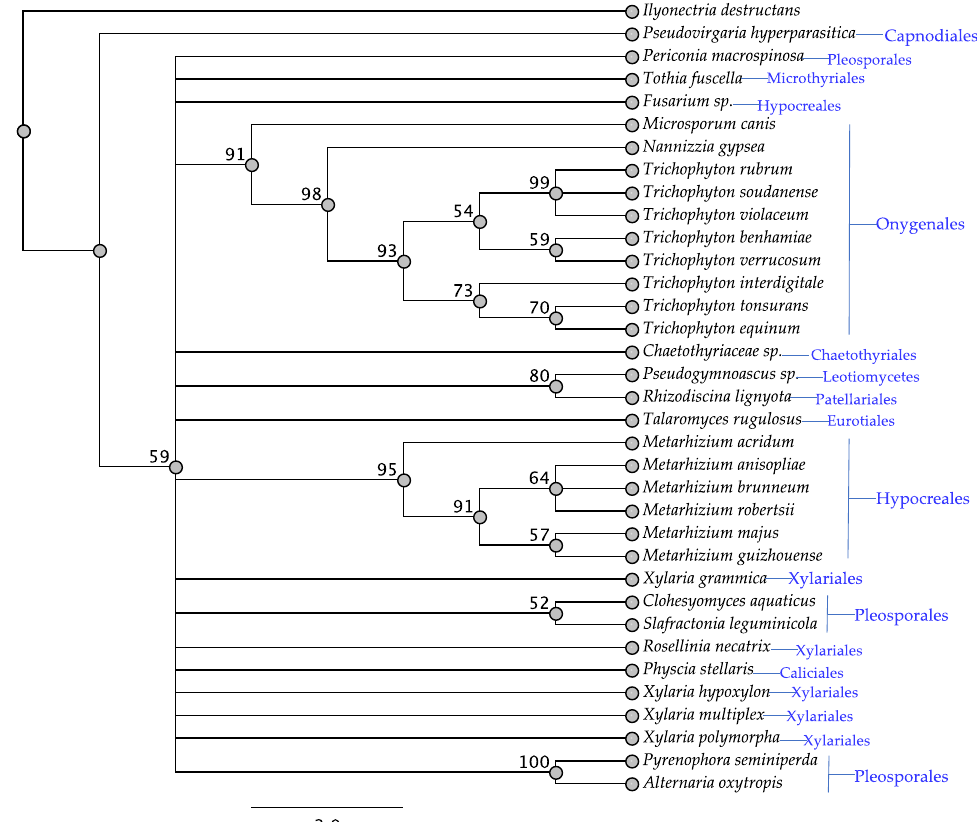
Figure 5. Maximum parsimony protein tree resulting from the analysis of SwnR. Bootstrap confidence values from 1000 bootstrap replicates are presented at each corresponding node. Ilyonectria destructans (Hypocreales) was used as the outgroup and obtained from NCBI database, GenBank accession: KAH7007559.1. Fungal orders are indicated next to each organism/clade.